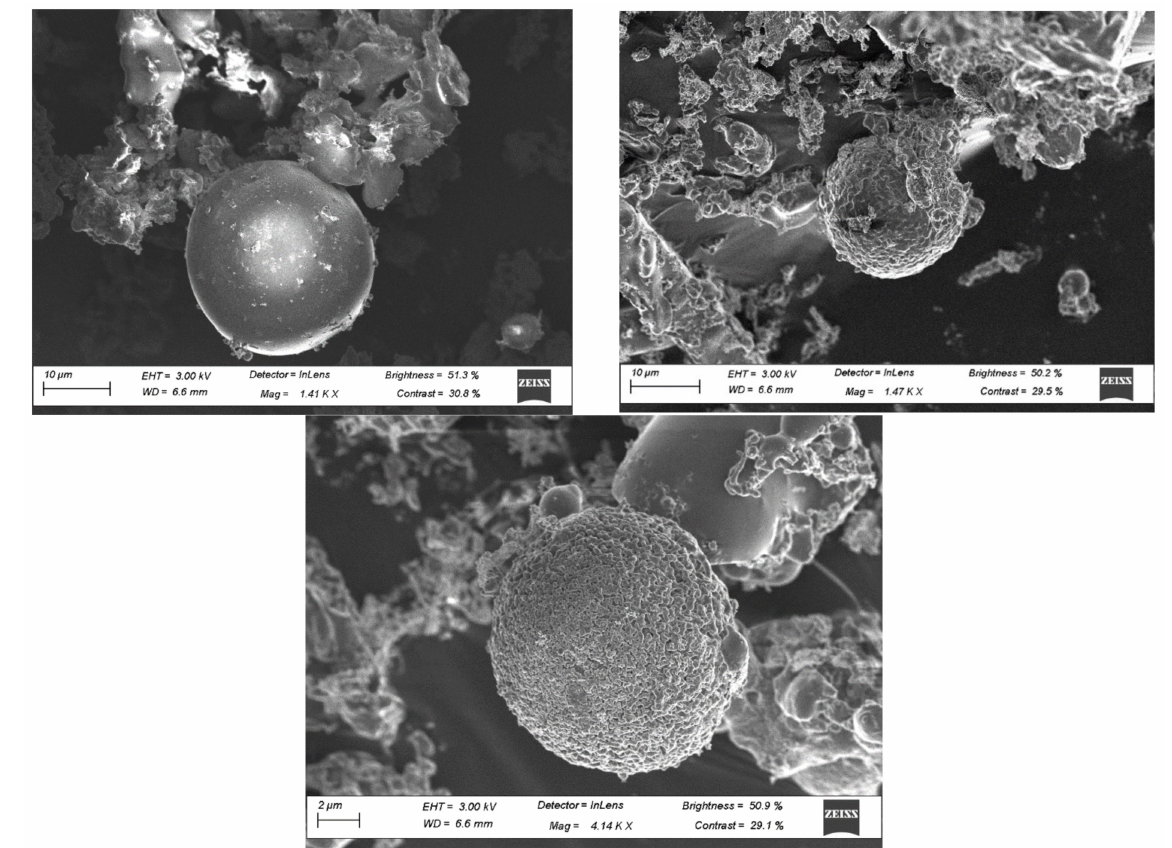
Figure 3. SEM results of Raw